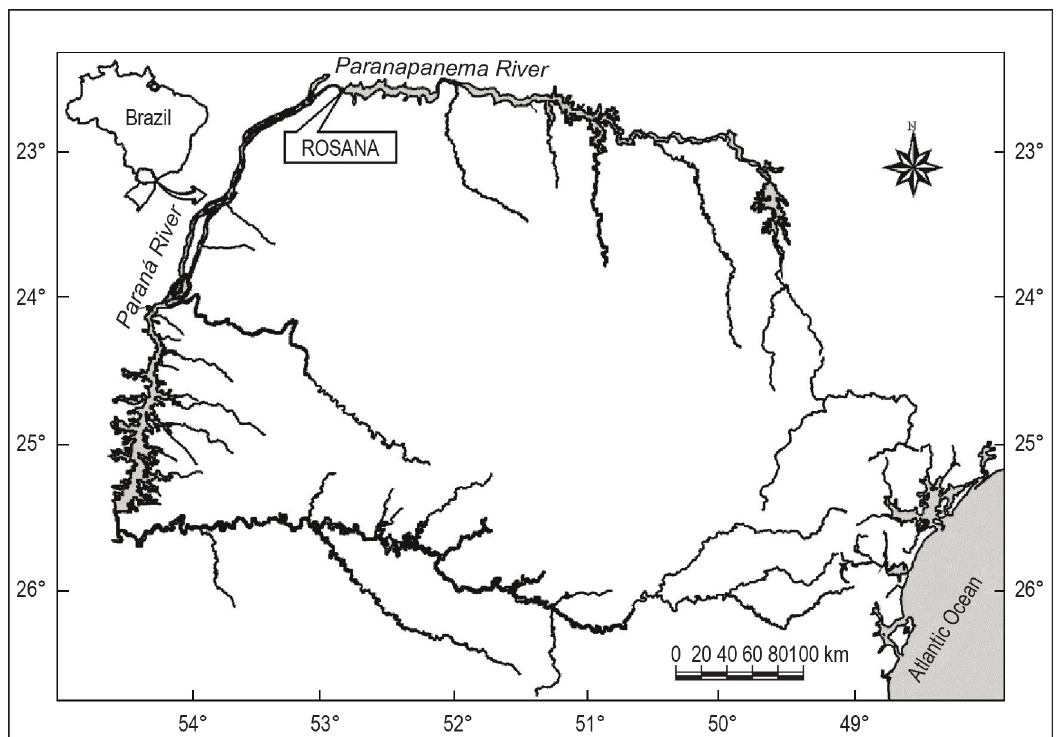
Figure 1. Map of the localization of Rosana Reservoir (River Paranapanema